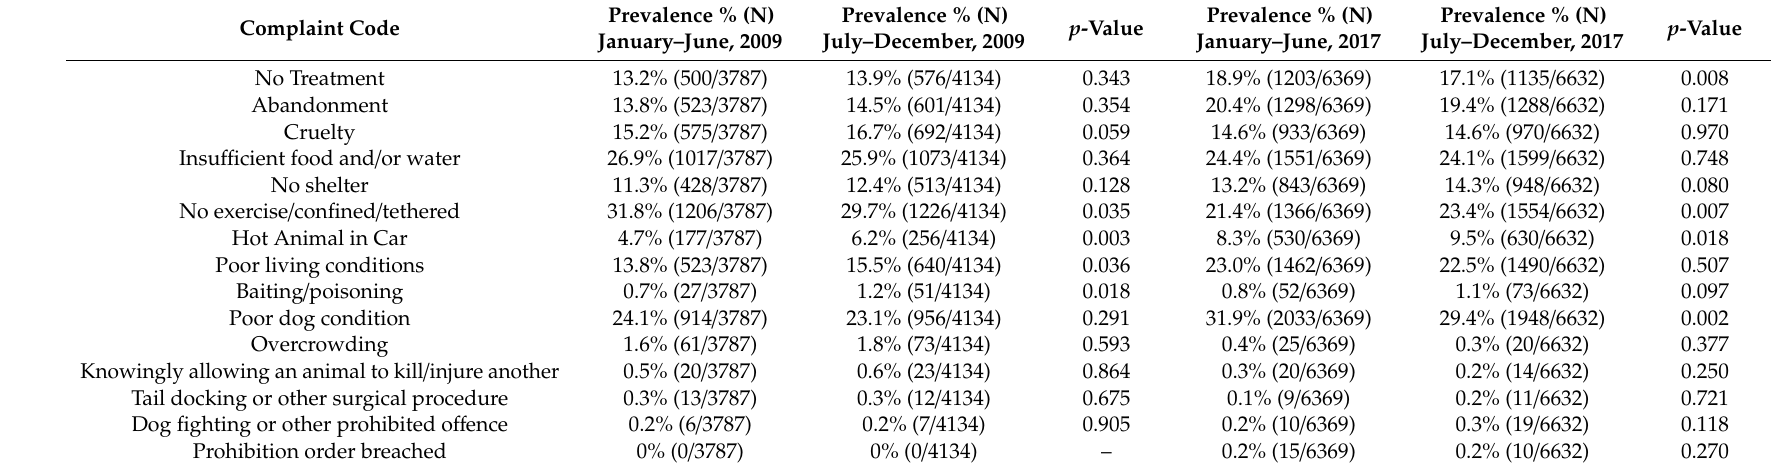
Table A2. Chi-squared tests comparing prevalence of di ff erent complaint codes in two six-month periods, from January to June and from July to December, in 2009 and